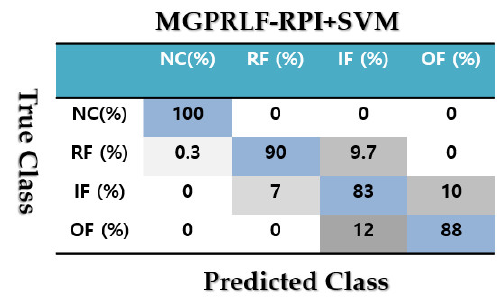
Figure 9. The average accuracies of crack identification using the MGPRLF-RPI+SVM technique.